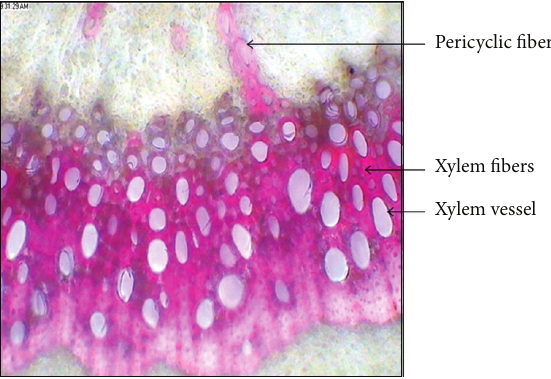
Figure 5: Midrib portion with lignified xylem (40x).